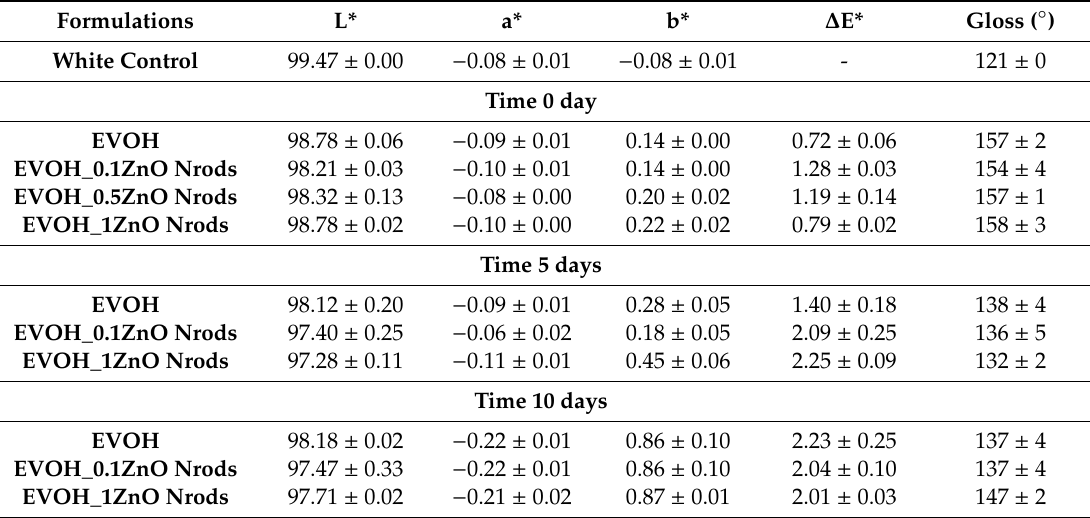
Table 1. Color coordinates of EVOH-based systems before and after di ff erent exposition times during the accelerated-aging